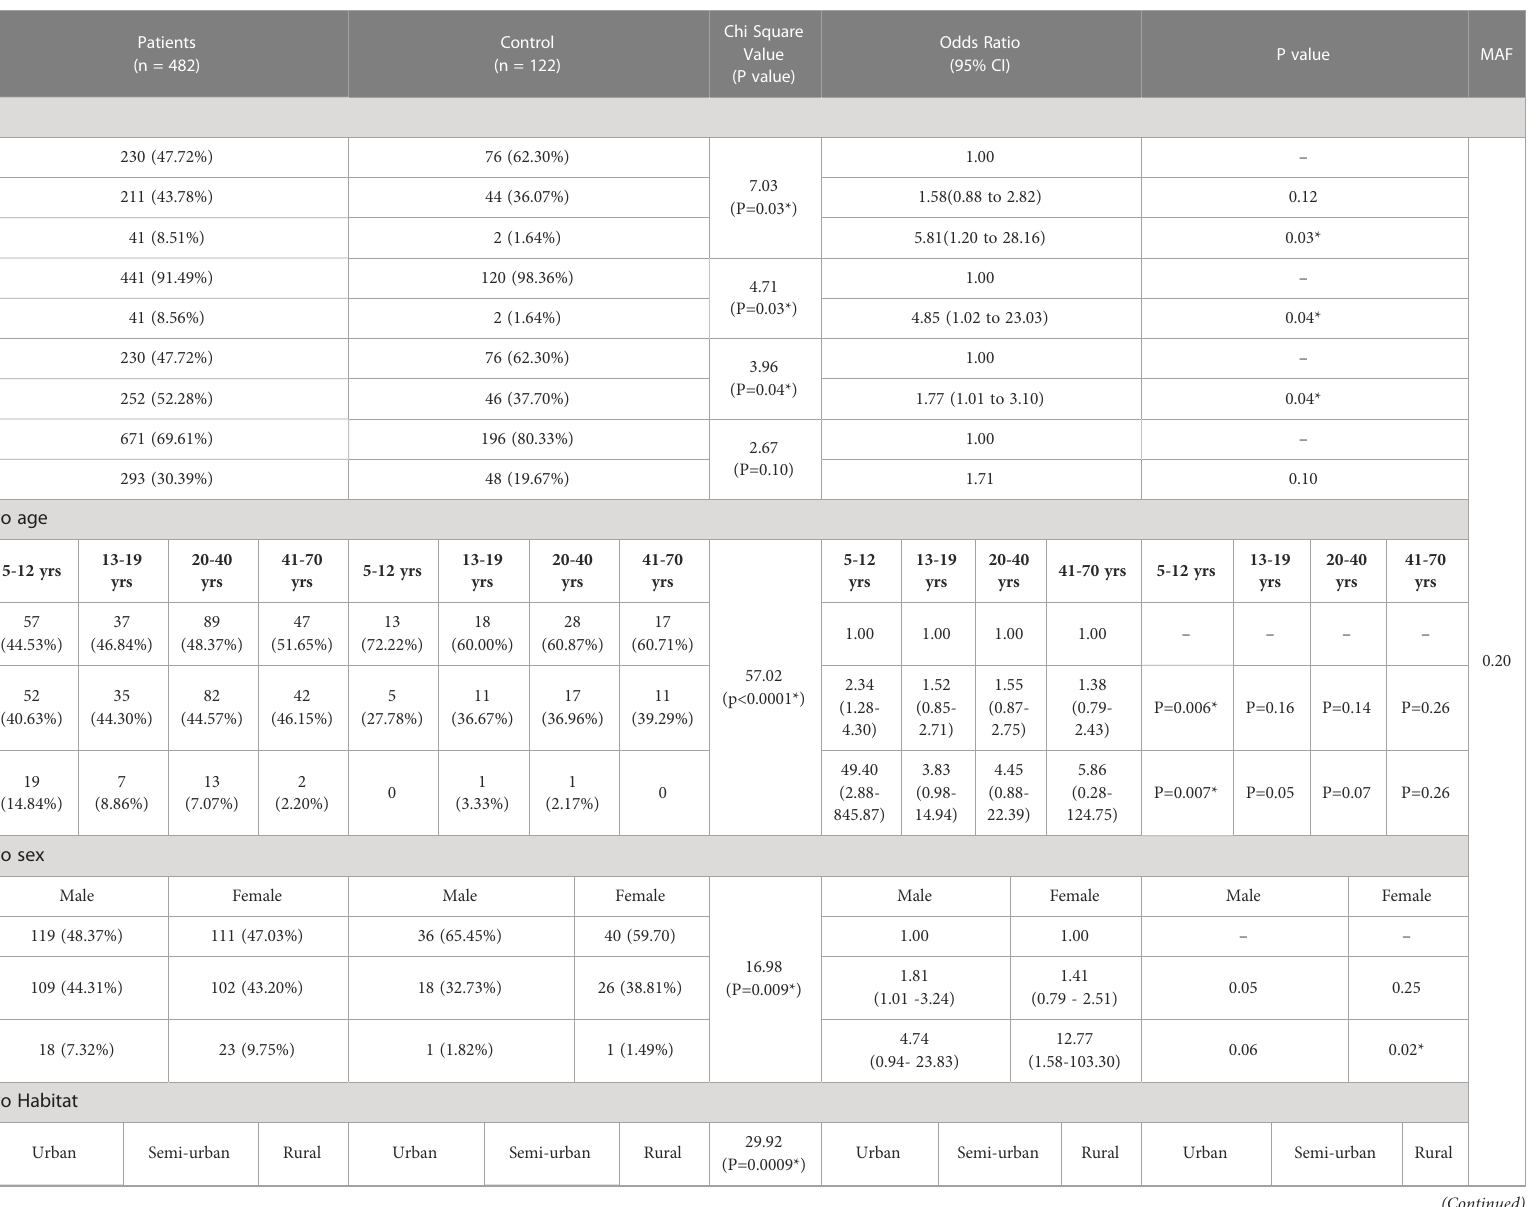
TABLE 3 Genotypic frequency distribution of TBXA2R rs34377097 polymorphism in cases and